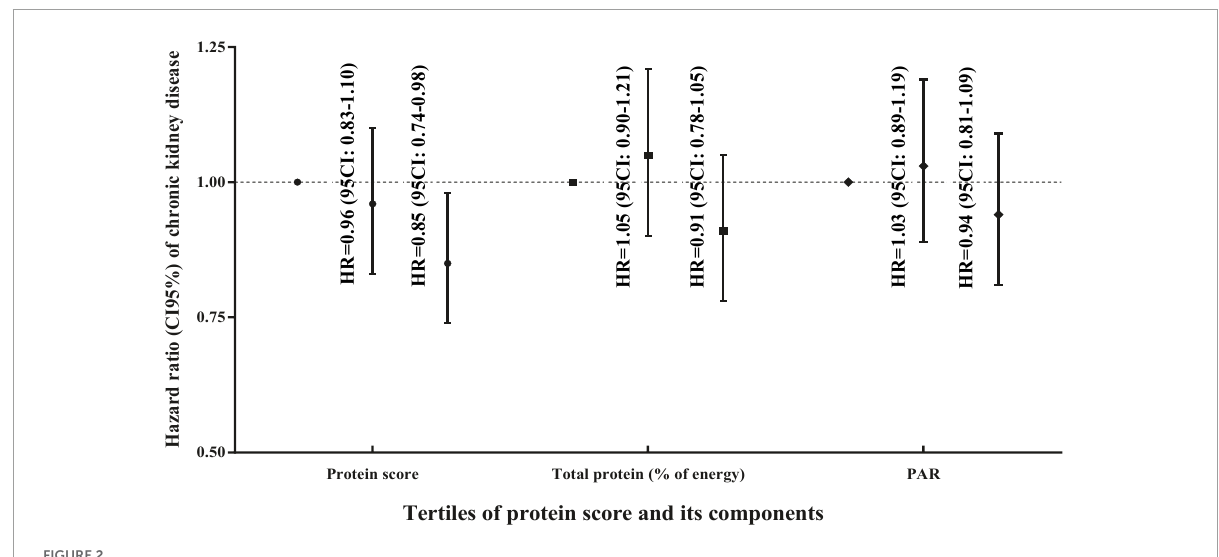
FIGURE2 Hazard ratio (95% confidence interval) of chronic kidney disease across tertile protein score and its components based on the multivariable model.